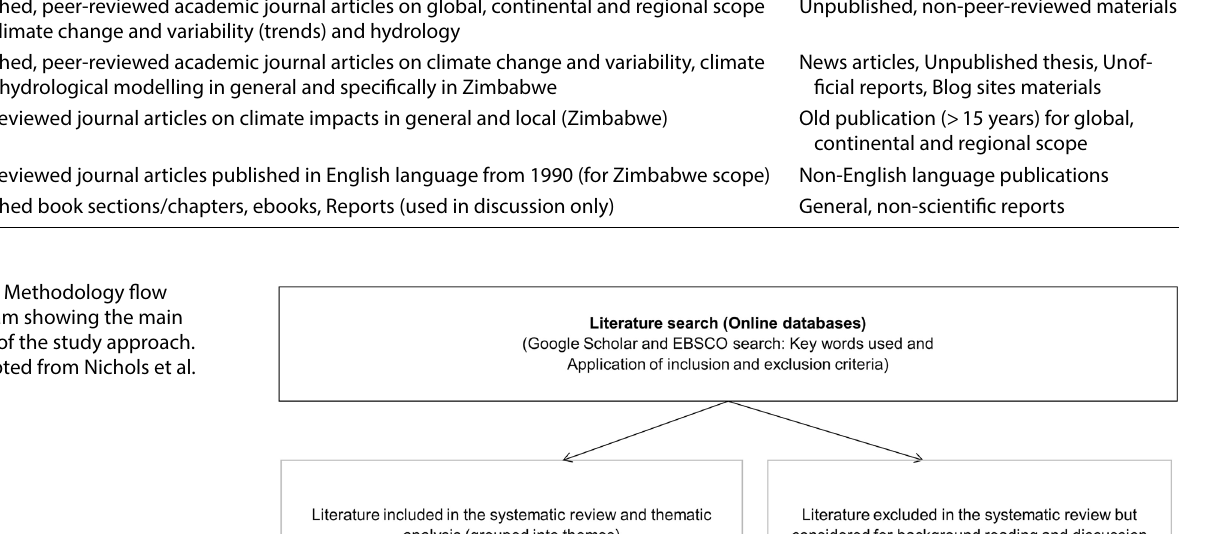
Table 1 Literature inclusion and exclusion criteria summary used to select articles covered in the review Inclusion criteria